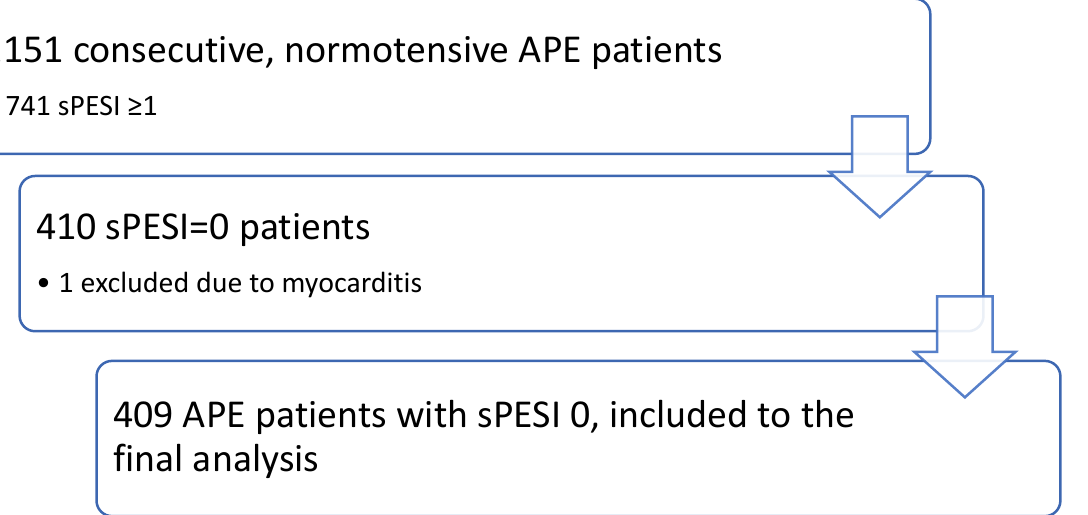
Figure 1. Flow of patients.